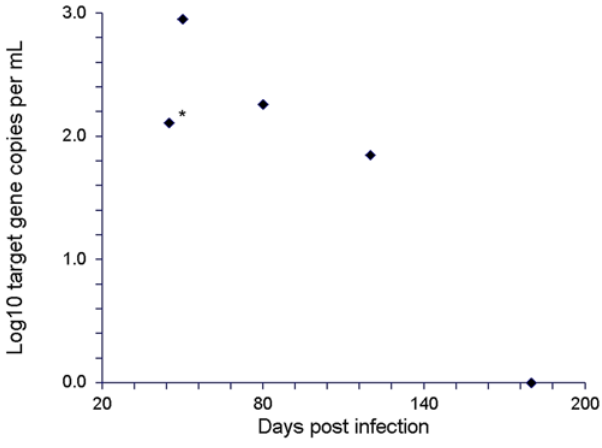
Figure 1. DNA copies per mL of pooled mouse plasma (y-axis, four mice per datum point) in mice infected intraperitoneally with 100 cercariae of S. mansoni . After completion of parasite maturation on day 42, mice were treated orally with praziquantel on day 45 (120 mg per kg). At the indicated times (x-axis), four mice were sacrificed, their blood pooled, and 1 mL of pooled plasma was tested as described in the Materials and Methods section for cell-free Schistosoma DNA. The untreated group is marked with an asterisk (*).